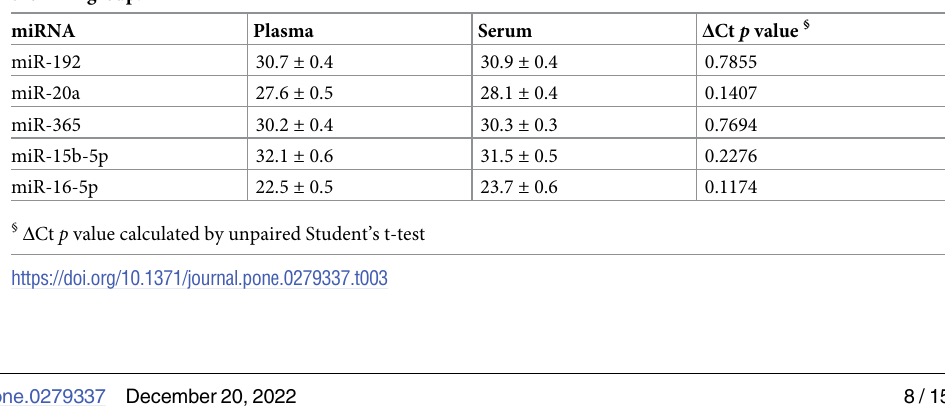
Table 3. Cycle threshold values (mean ± SEM) for microRNA derived from feline plasma and serum samples of the PKD